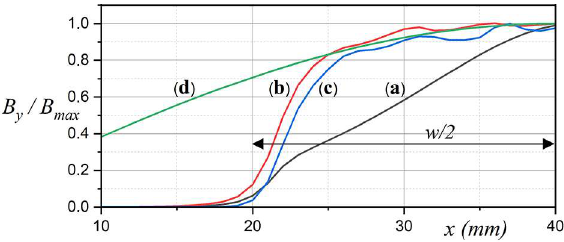
Figure 10 . Magnetic field distribution over the symmetric magnetic pole of SM (normalized values). Comparison: constant P y magnetization ( a ); variable P y magnetization ( b ); variable P x and P y magnetization ( c ); distribution given by Equation (19) ( d ).